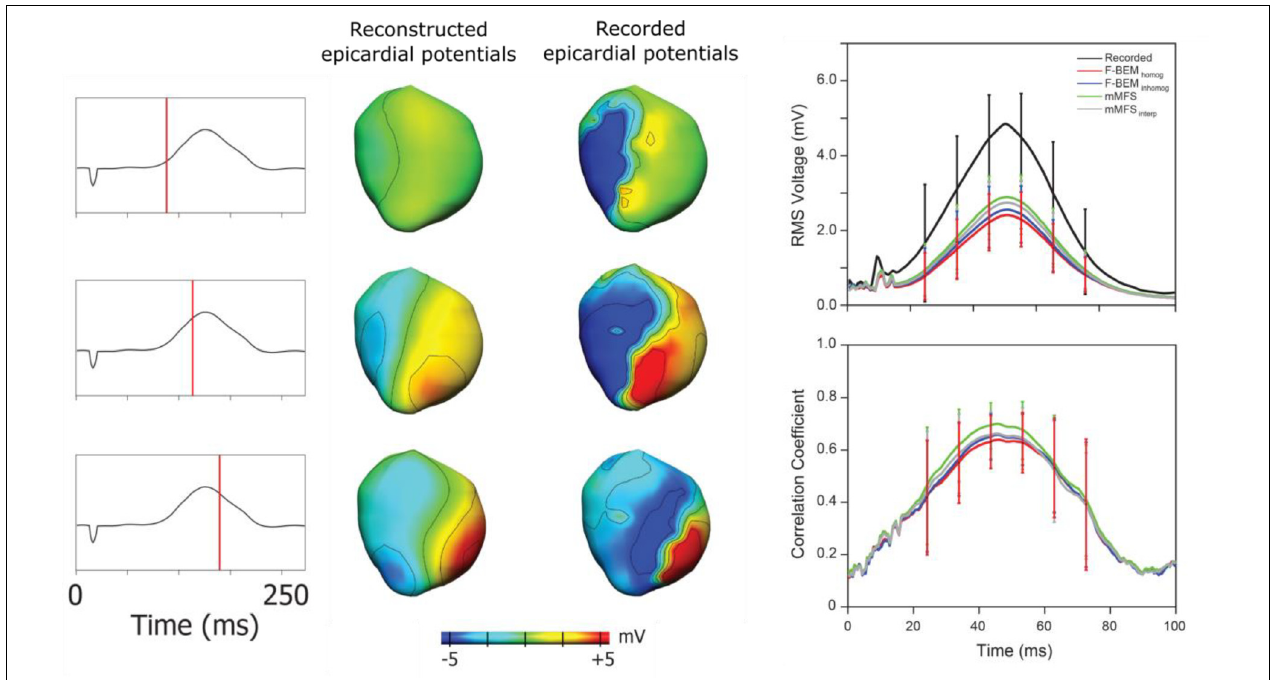
FIGURE 4 | Epicardial potential maps derived from ECGI (left) and recorded (right) epicardial electrograms at three instants during ventricular activation during epicardial pacing from the anterior RV free wall (ECG shown left). During the early and late phases of activation, only small regions of the heart are activated, leading to distorted values of error metrics such as correlation (right, showing different reconstruction approaches in different colors). Adapted with permission from Bear et al.